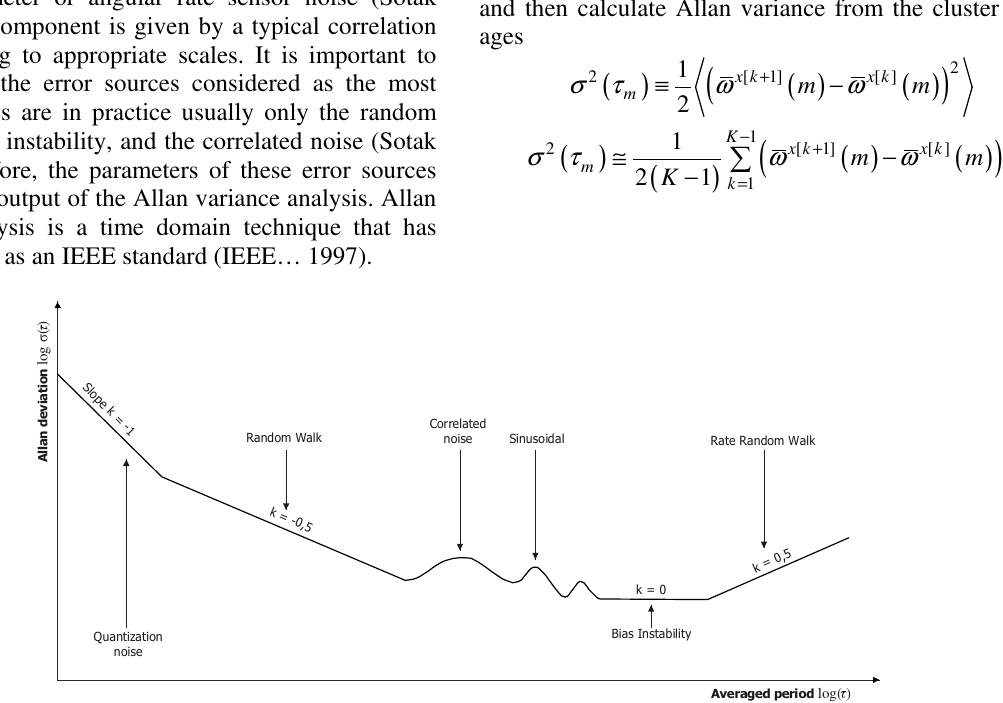
Fig. 1. Sample plot of Allan variance analysis results (Sotak 2009; Sotak